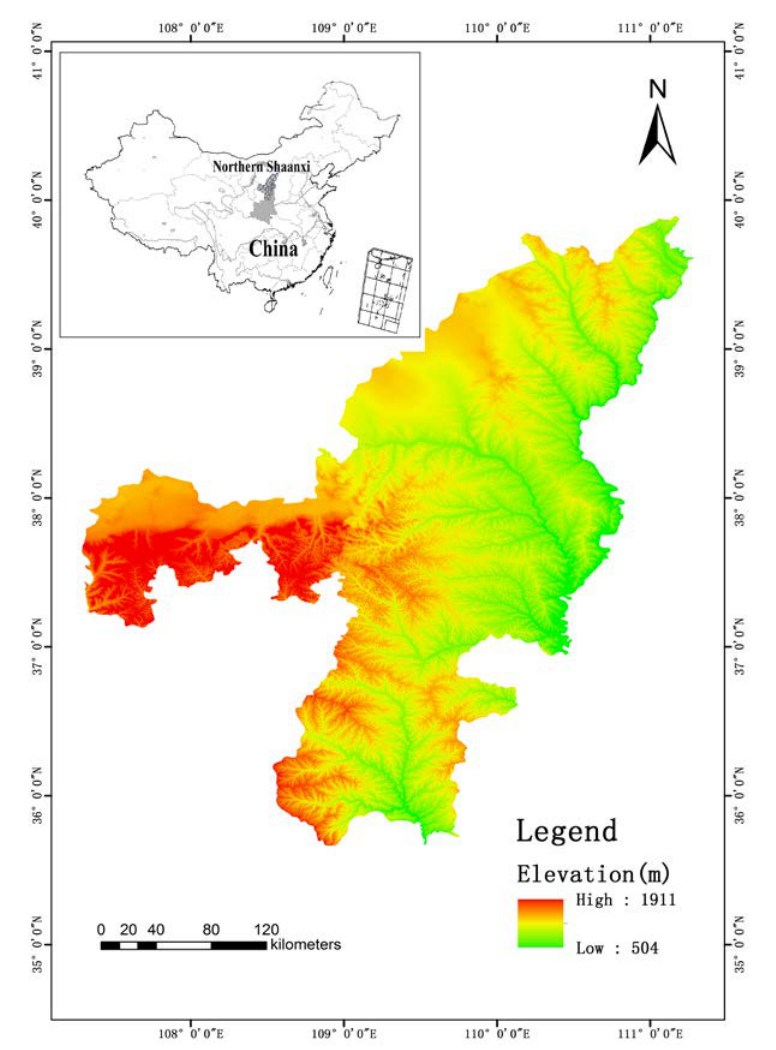
Figure 1. The location of the study